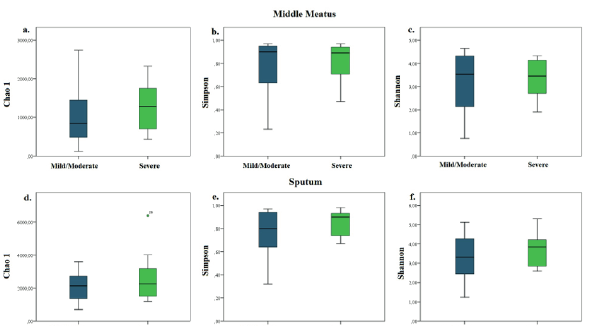
Figure 3. Alpha diversity in sample sites according to lung disease sever- ity (blue: mild/moderate; green: severe). a. Chao1 richness estimator, b. Simpson´s dominance and c. Shannon´s diversity indexes from the middle meatus samples. d. Chao 1 richness estimator, e. Simpson´s dominance and f. Shannon´s diversity indexes from the sputum samples.